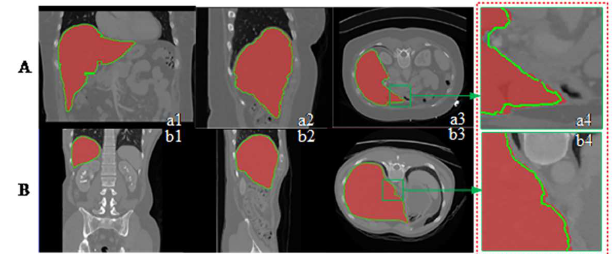
Fig 9. Segmentation results on different directions.